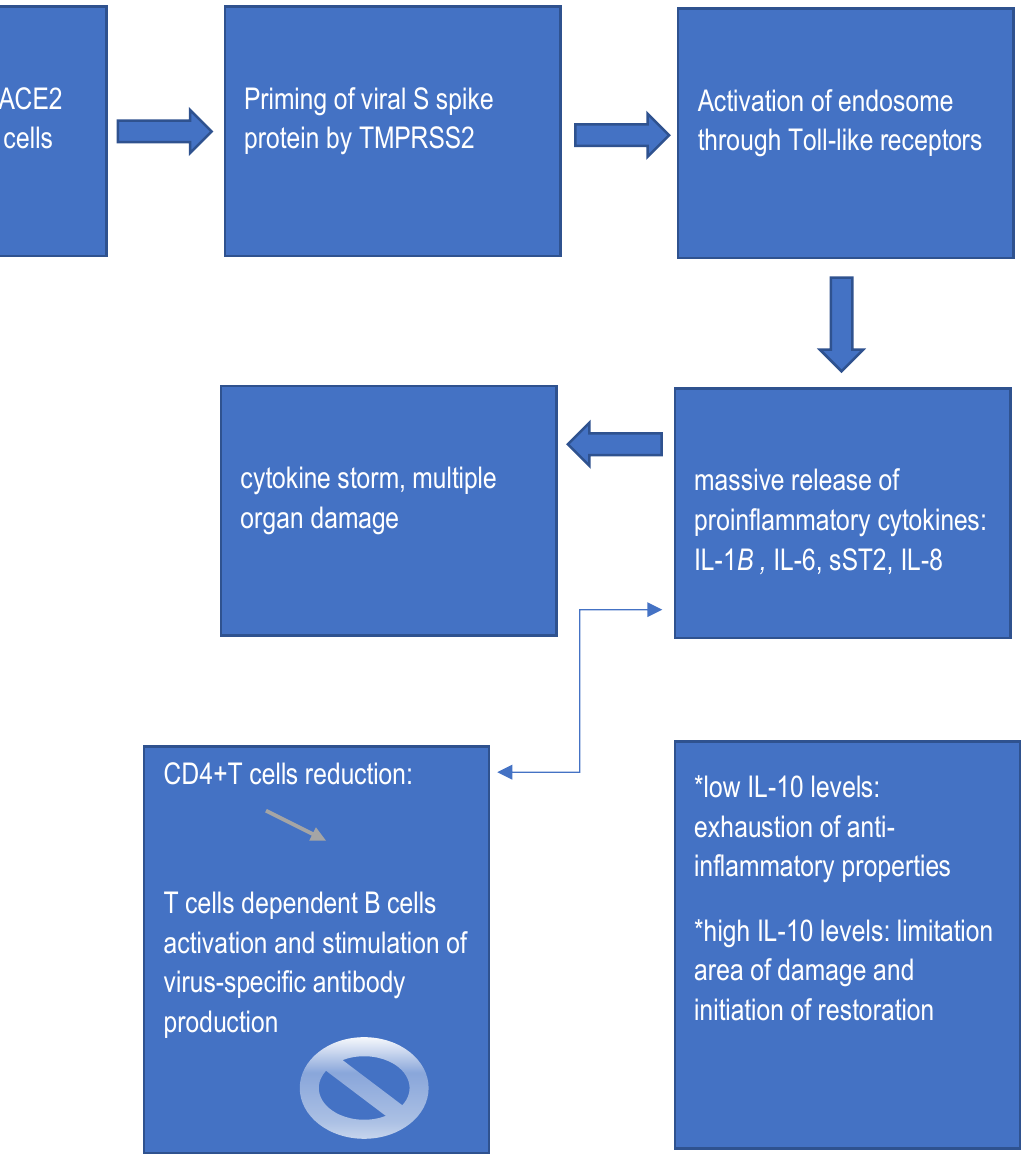
Figure 1. Pathogenetic mechanisms of cytokines involvement in